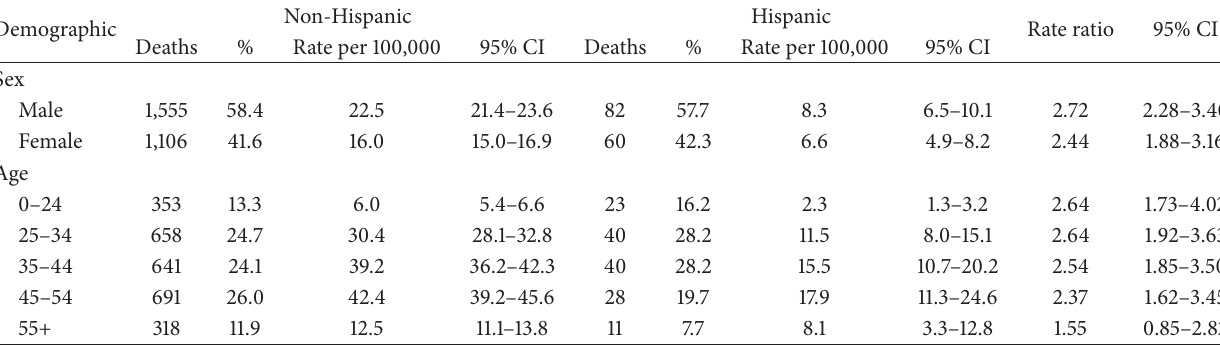
Table 1: Sex- and age-specific drug-related deaths in Utah according to ethnicity, 2005–2010.